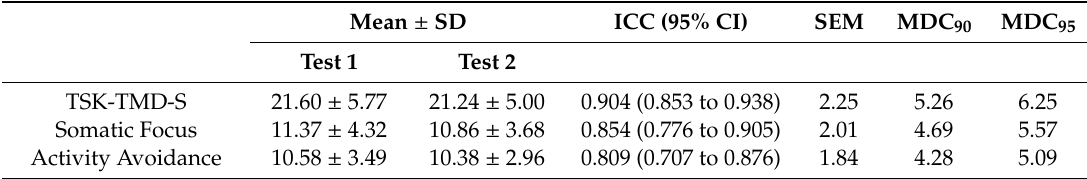
Table 3. Descriptive statistics, intraclass correlation coefficients (ICCs) and associated 95% confidence